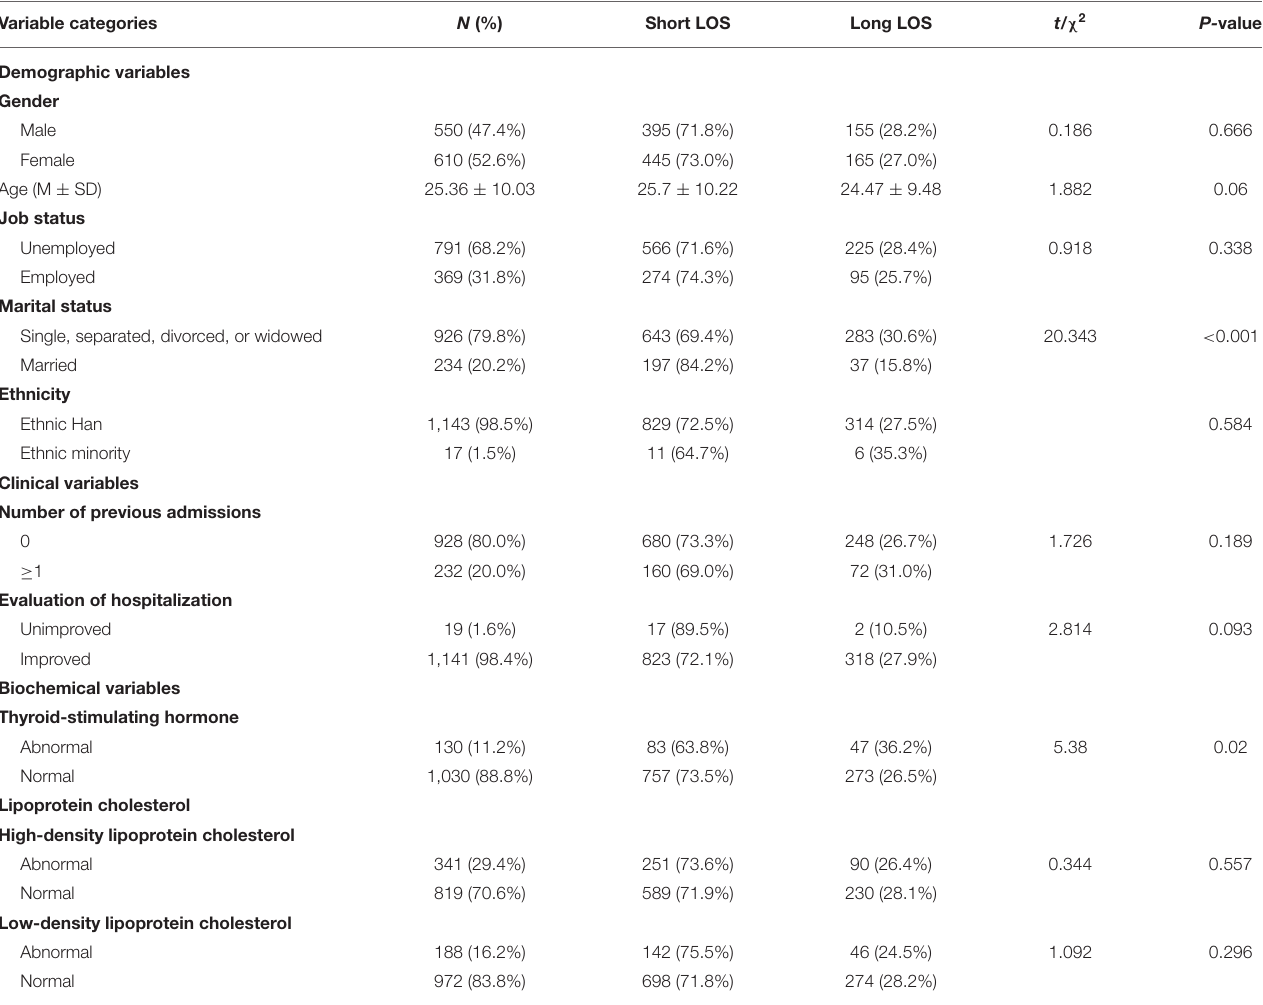
TABLE 1 | Univariate analysis of variables related to length of stay (LOS).